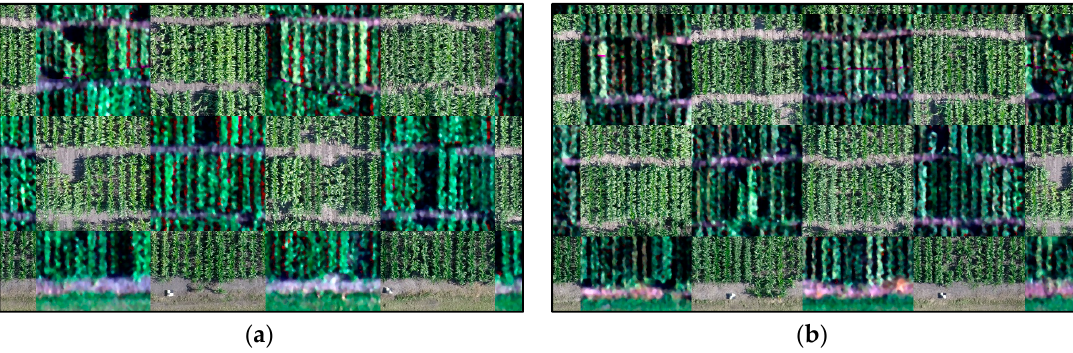
Figure 14. Close-up of chessboard orthophoto mosaics generated from the RGB-based orthophoto and refined hyperspectral orthophoto through the proposed approach: ( a ) acquired hyperspectral data on 4 August 2015 and ( b ) acquired hyperspectral data on 21 August 2015.